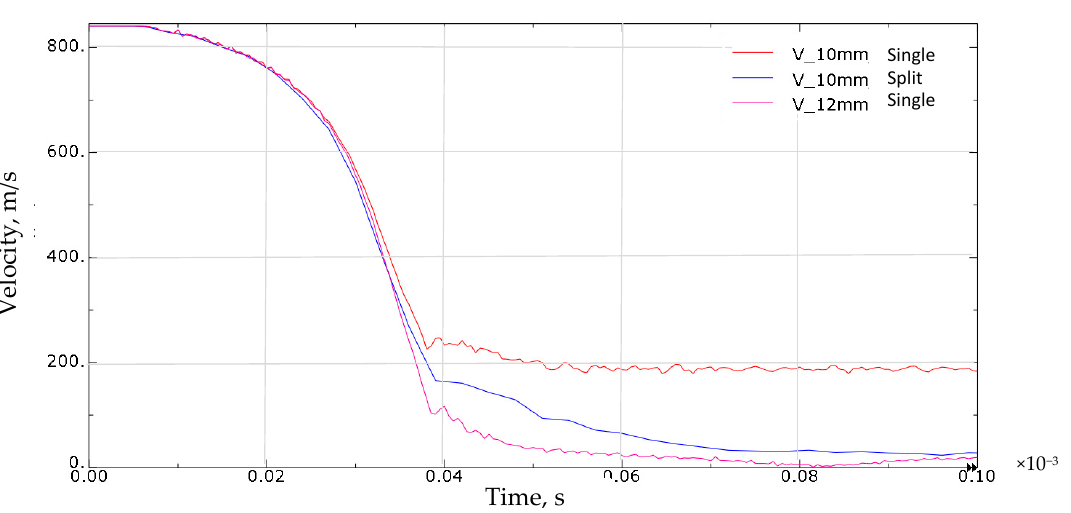
Figure 15. Projectile speed drop. Results of the FEM simulation for samples with a thickness of 10 mm (single and split) and 12 mm (single).